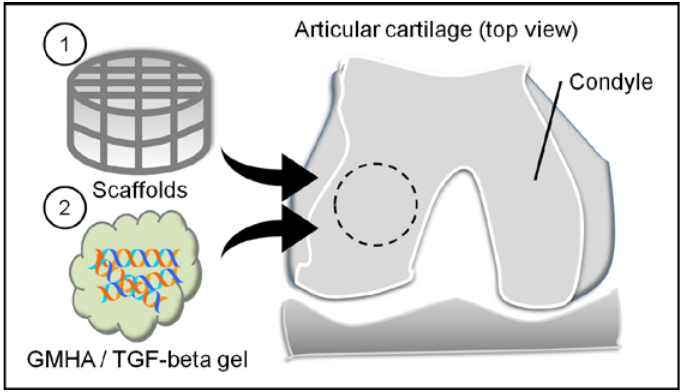
Figure 3. The illustration of animal model. Control group: create a bony defect 3 mm in diameter and 8 mm in depth without scaffold implantation. Experimental group: scaffolds and light-curing gel containing TGF-beta 1 were implanted into the defect, and cross-linked with 365 nm ultraviolet light.